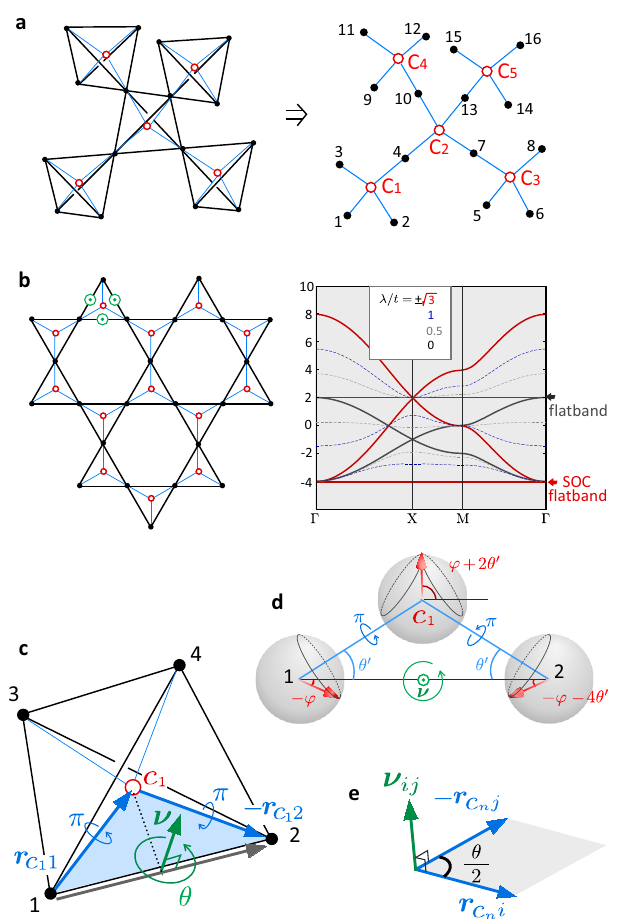
ffiffiffi p 3 are ¼ ð 1 ; (cid:2) 1 ; 1 Þ and r ¼ ð(cid:2) 1 ; 1 ; 1 Þ C 1 2 1 1 j is 8 times larger than the true 1 1